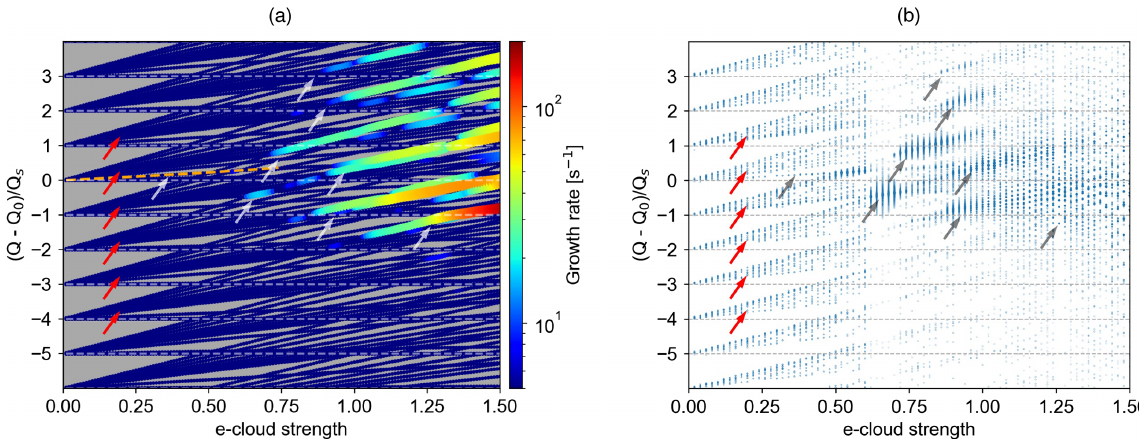
≠ 0 , Δ Q ≠ 0 . (a) Eigenvalues from linearized Vlasov equation, (b) P y HEADTAIL simulations Φ R